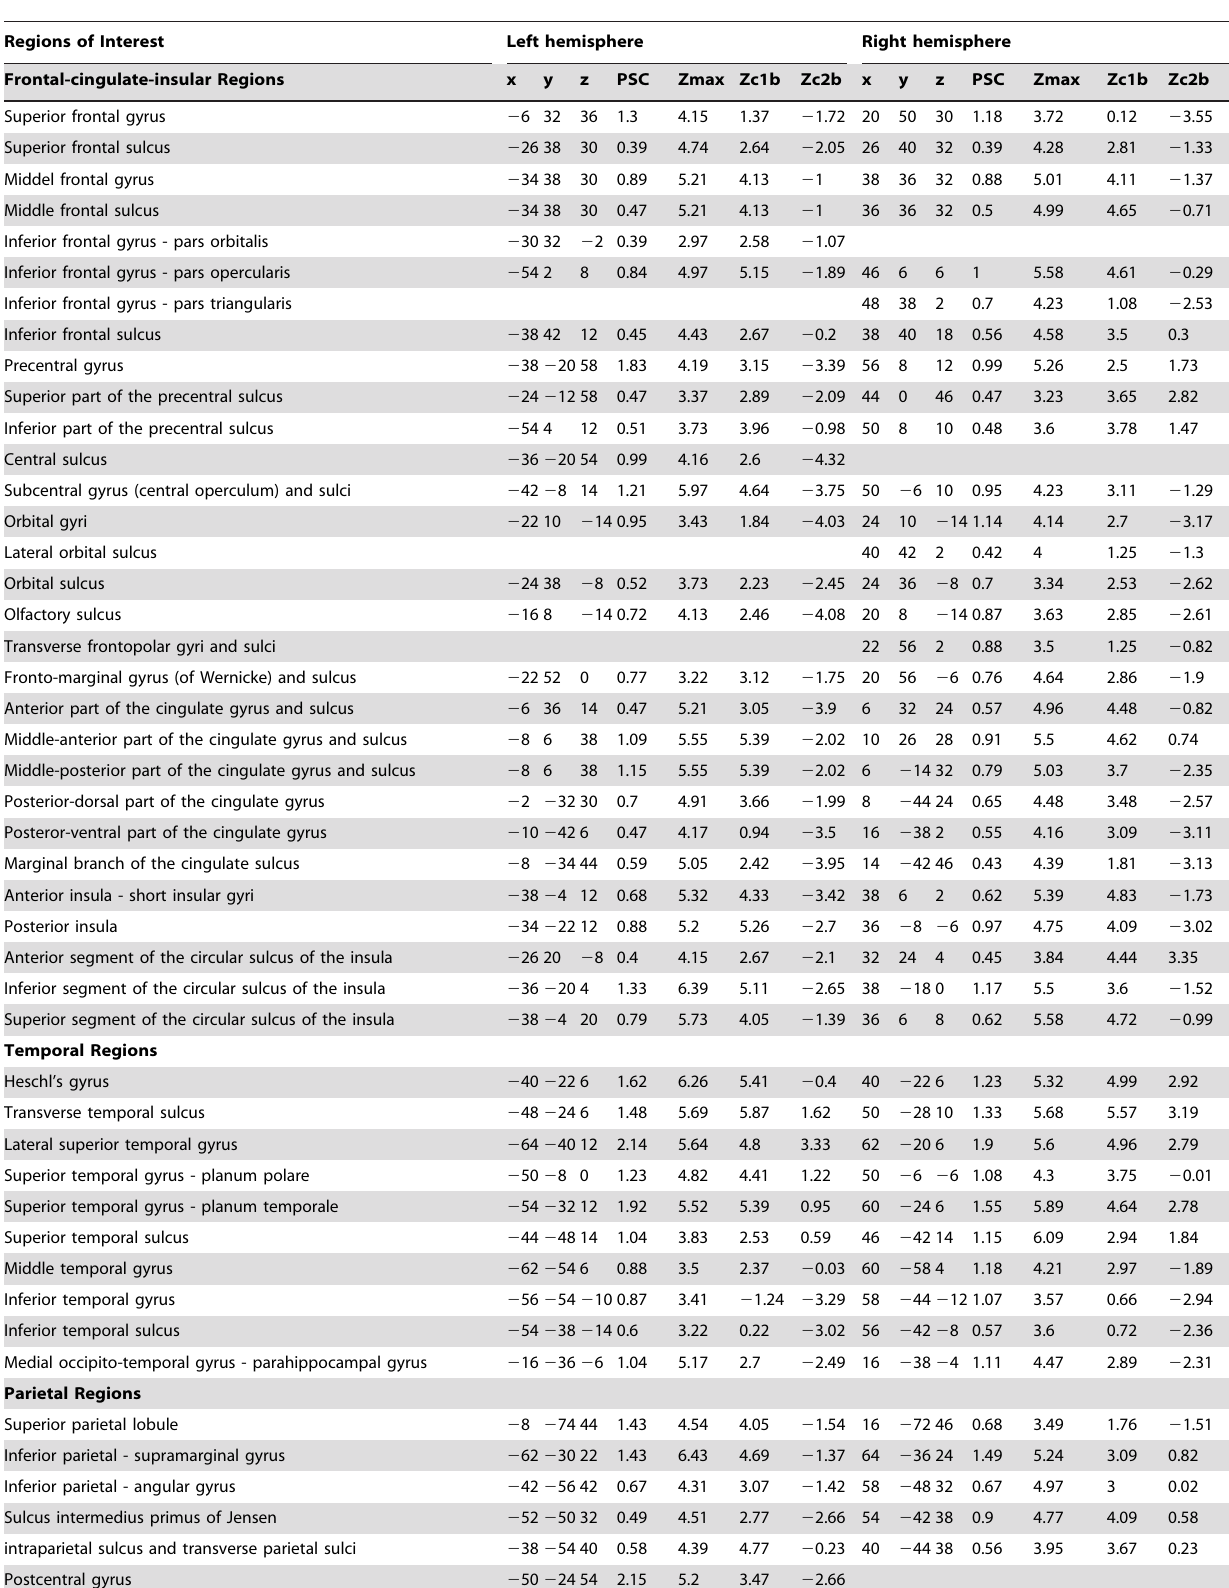
Table 3. Brain regions activated in the Cue + Target + Standards vs. Cue + Standards contrast.